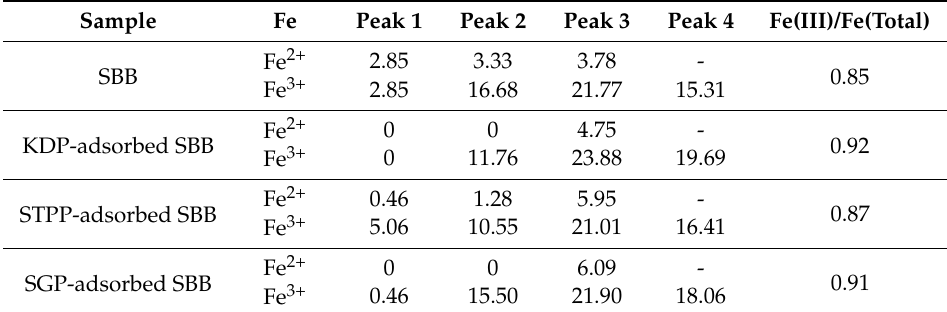
Table 5. Relative contents of Fe(II) and Fe(III) multiple peaks in Fe (2p 3/2 ) XPS fitting curves (Percent of total peak area, %) and Fe(III) to Fe total surface